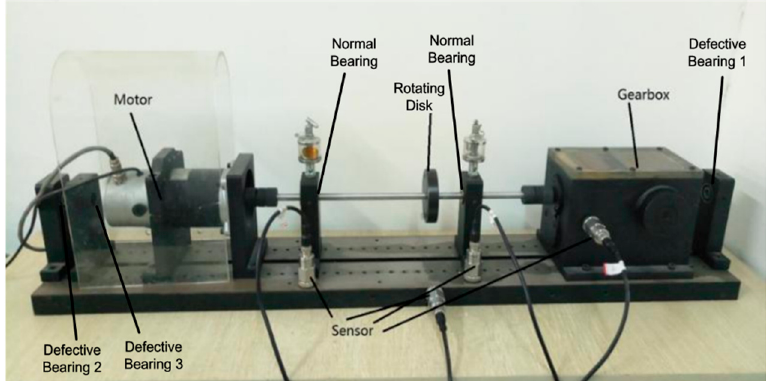
Figure 16. Experiment platform of bearing in Henan University.